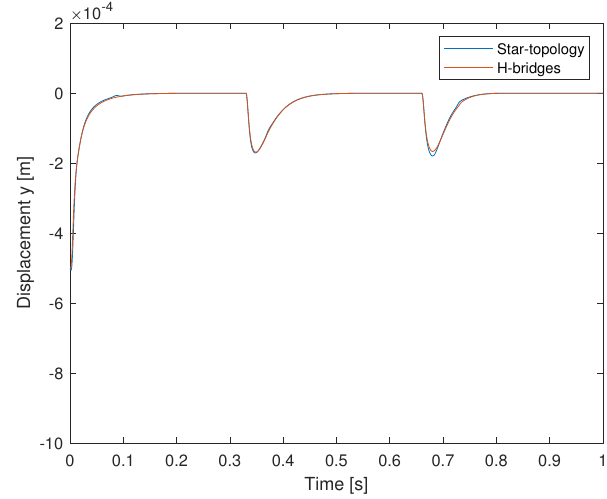
Figure 13. Displacement comparison on